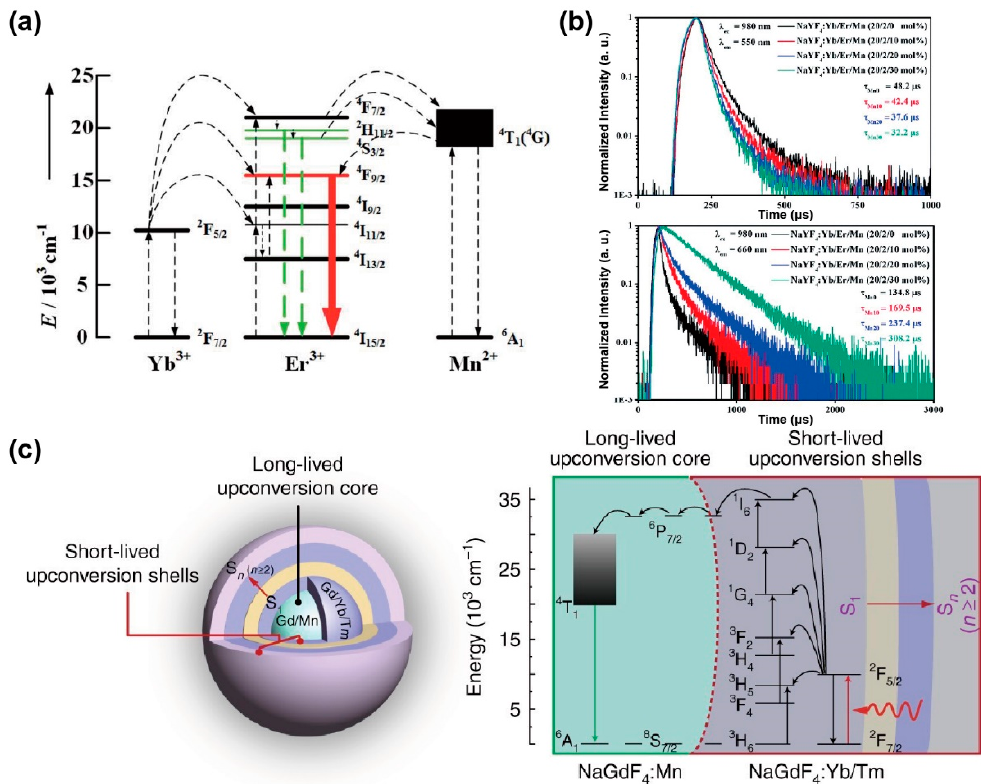
Figure 4. ( a ) The diagram for energy transfer mechanism among Yb 3+ , Er 3+ and Mn 2+ under 980 nm excitation. ( b ) Luminescence decay curves of Er 3+ at 550 nm and 650 nm in NaYF 4 :Yb 3+ /Er 3+ nanoparticles with different Mn 2+ concentrations (0, 10, 20 and 30 mol%). Reproduced with permission from [34]. Copyright 2016, Royal Society of Chemistry. ( c ) Structural design of core–multishell nanoparticle and the energy transfer pathway among the Yb 3+ , Tm 3+ , Gd 3+ and Mn 2+ ions for the short- and long-lived upconversion luminescence under 980 nm excitation. Reproduced